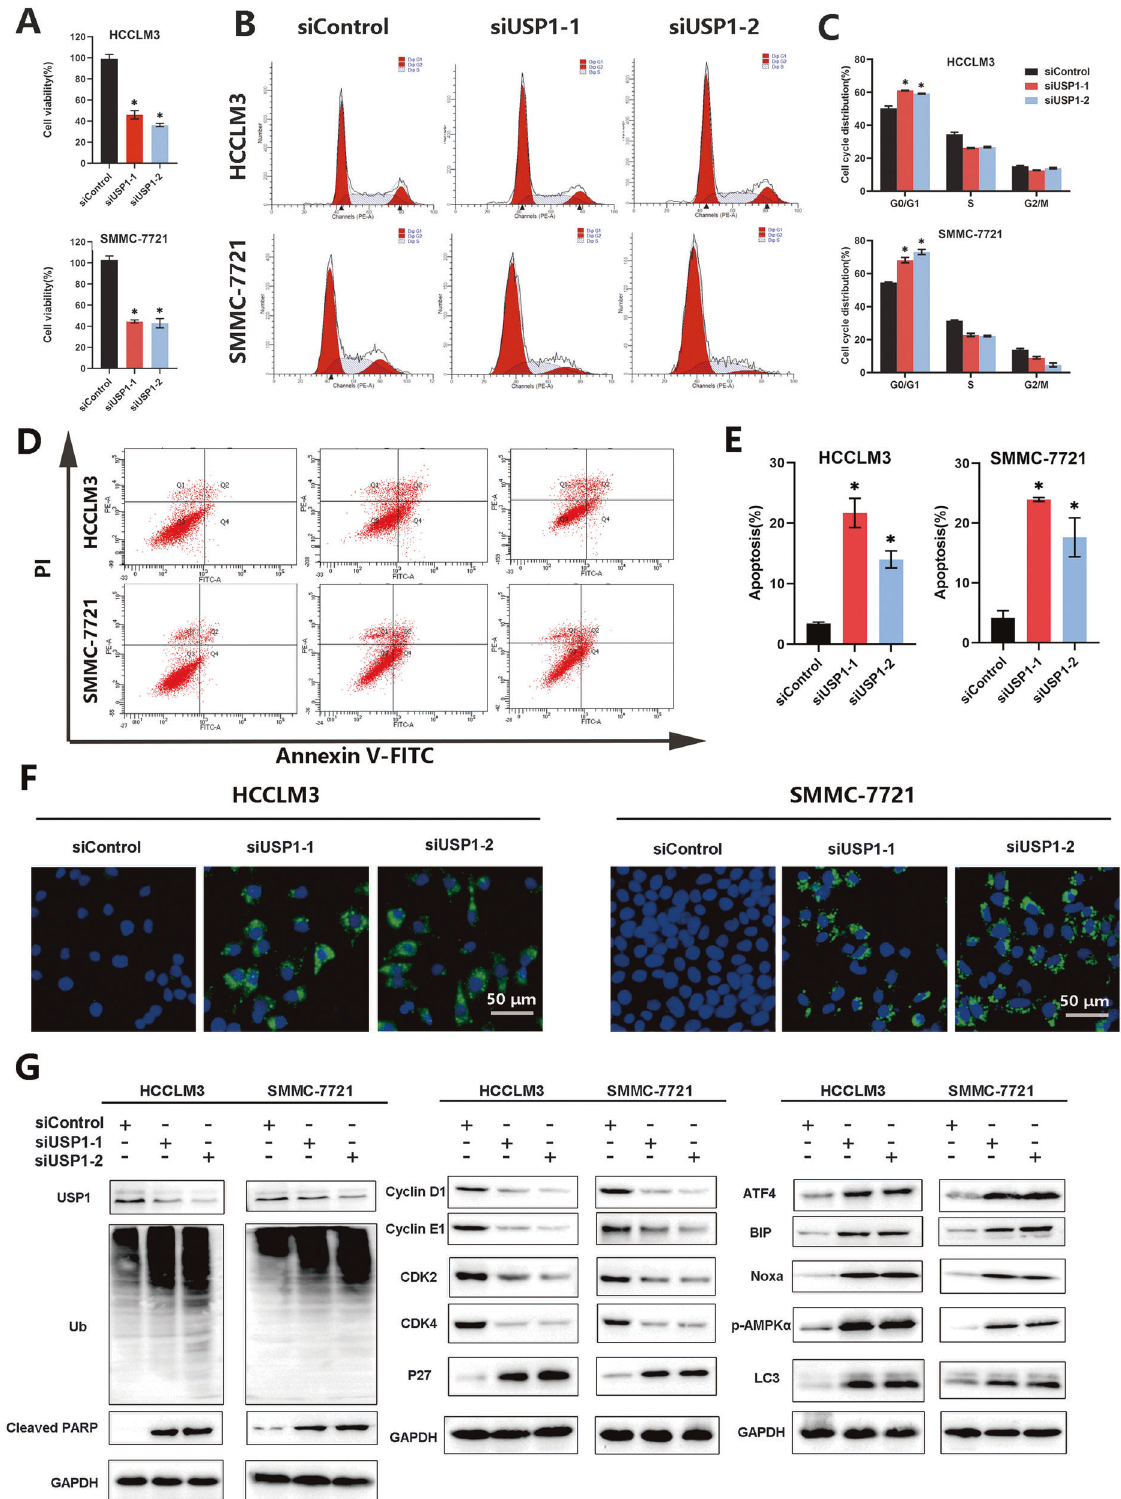
Fig. 7 Effects of USP1 gene inactivation on HCC cells. A Cell-counting kit 8 assay showing the viability of HCCLM3 and SMMC-7721 cells treated with siControl and siUSP1 at 24, 48, and 72 h. B Flow cytometry analysis using an Annexin V-FITC/PI double-staining kit to detect apoptosis in HCCLM3 and SMMC-7721 cells treated with siControl and siUSP1 for 48 h. C Flow cytometry showing the cell cycle of HCCLM3 and SMMC-7721 cells treated with siControl and siUSP1 for 24 h. D LC3B immuno fl uorescence assay in HCCLM3 and SMMC-7721 cells treated with siControl and siUSP1. E Western blot analysis of HCCLM3 and SMMC-7721 cells treated with siControl and siUSP1. F GAPDH was used as a loading control. Data represent at least three independent experiments ( n = 3; error bar, SD); scale bars = 50 μ m.